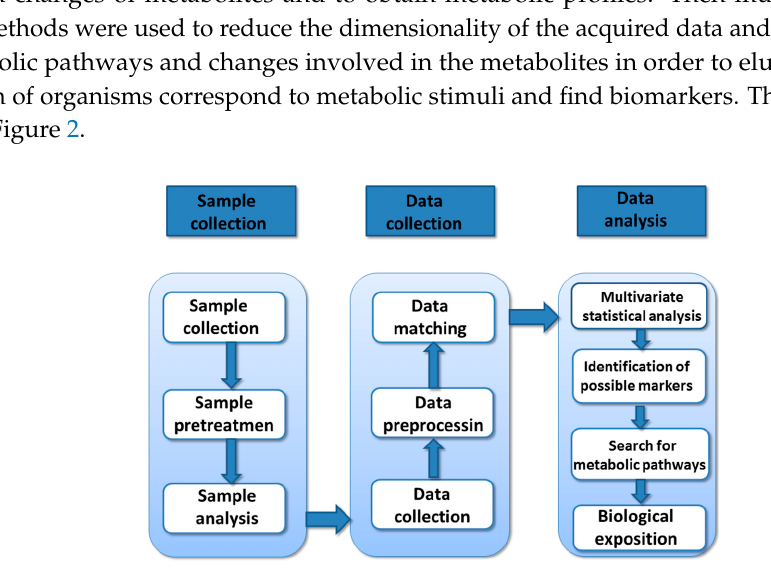
Figure 2. Process flow chart of metabonomics research.